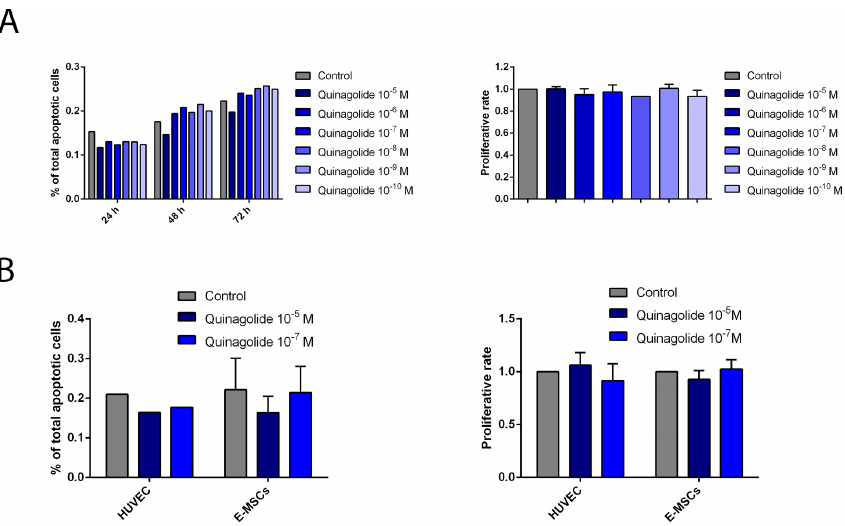
Figure 3. Quinagolide effect on E-MSC apoptosis and proliferation. ( A ) Quinagolide concentration- response curve on ectopic E-MSCs in both apoptosis ( n = 1) and proliferation ( n = 2) assays. ( B ) Effect of two selected quinagolide doses (10 − 5 and 10 − 7 M) on HUVECs ( n = 1) and ectopic E-MSCs ( n = 3) apoptosis and proliferation assays ( n = 2). Data are represented as mean ± SD of the indicated number of experiments and normalized to untreated cells